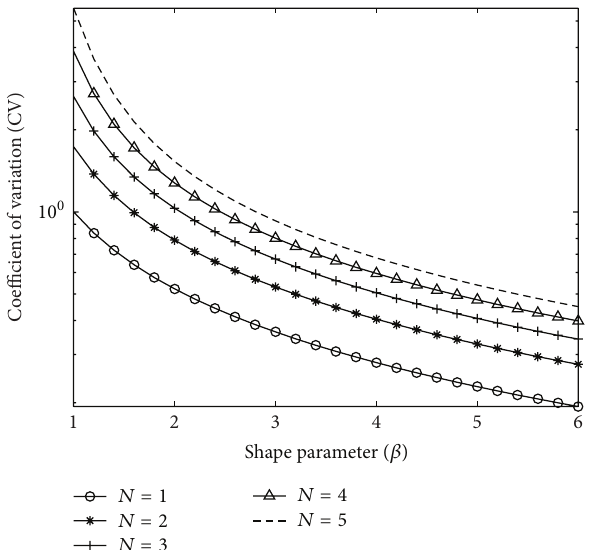
Figure 2: Coefficient of variation against 𝛽 for various number of